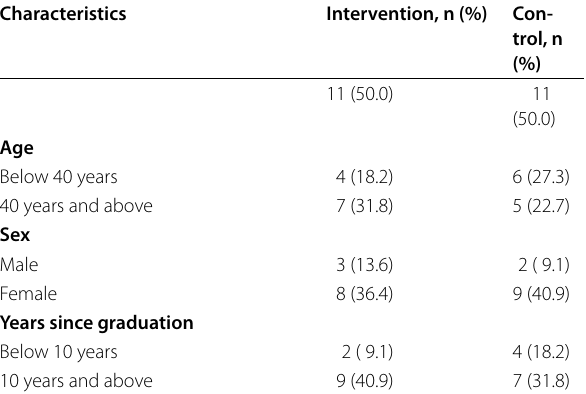
Table 2 Baseline characteristics of primary care physicians by treatment group